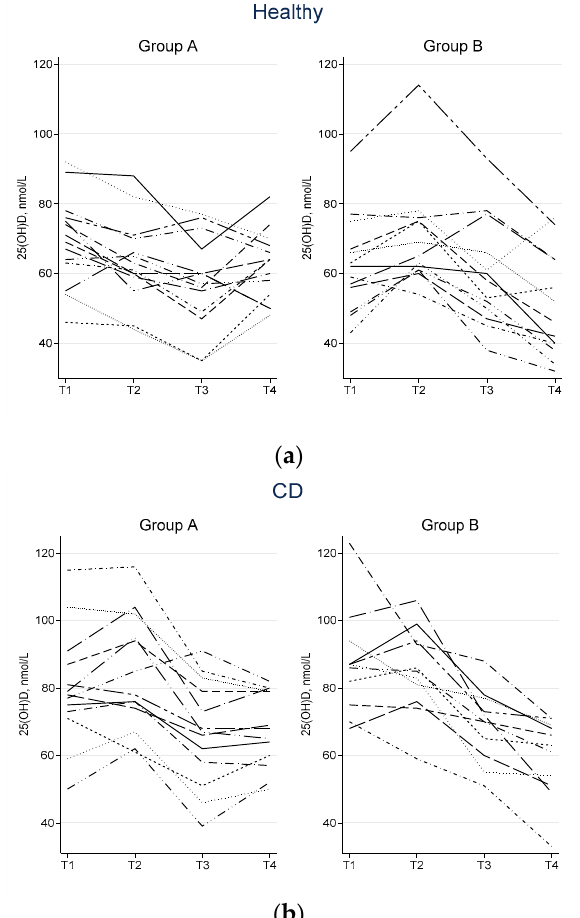
Figure 4. Individual participant profiles of vitamin D measurements across the study time points for ( a ) heathy trial and ( b ) Crohn’s disease trial.